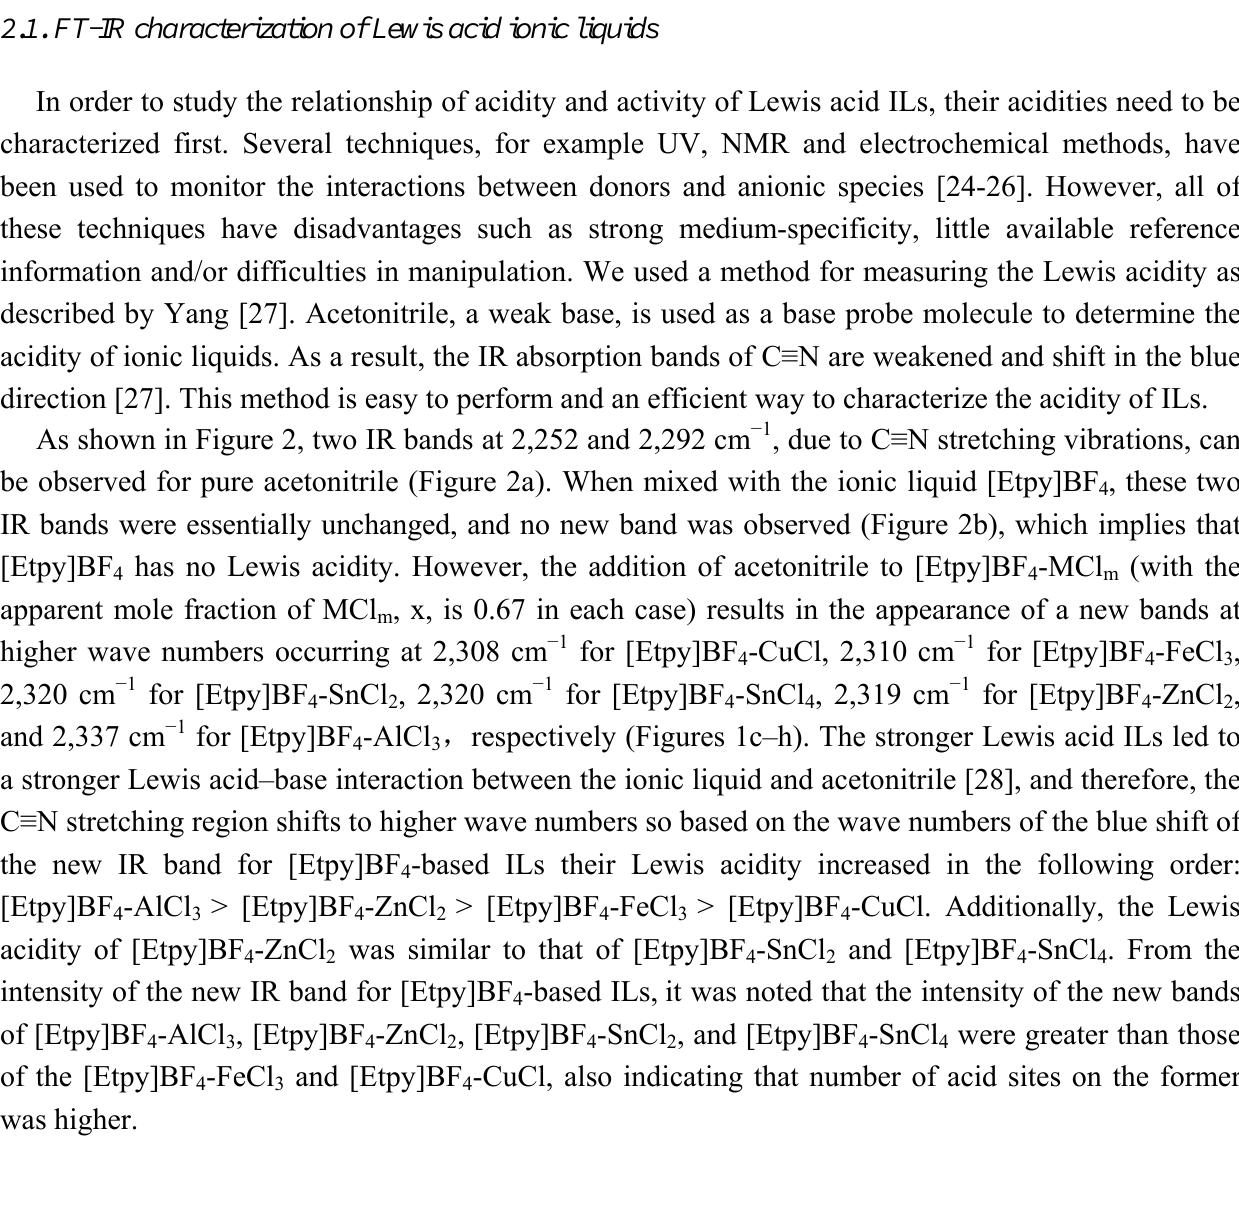
Figure 1. The structure of [Etpy] BF